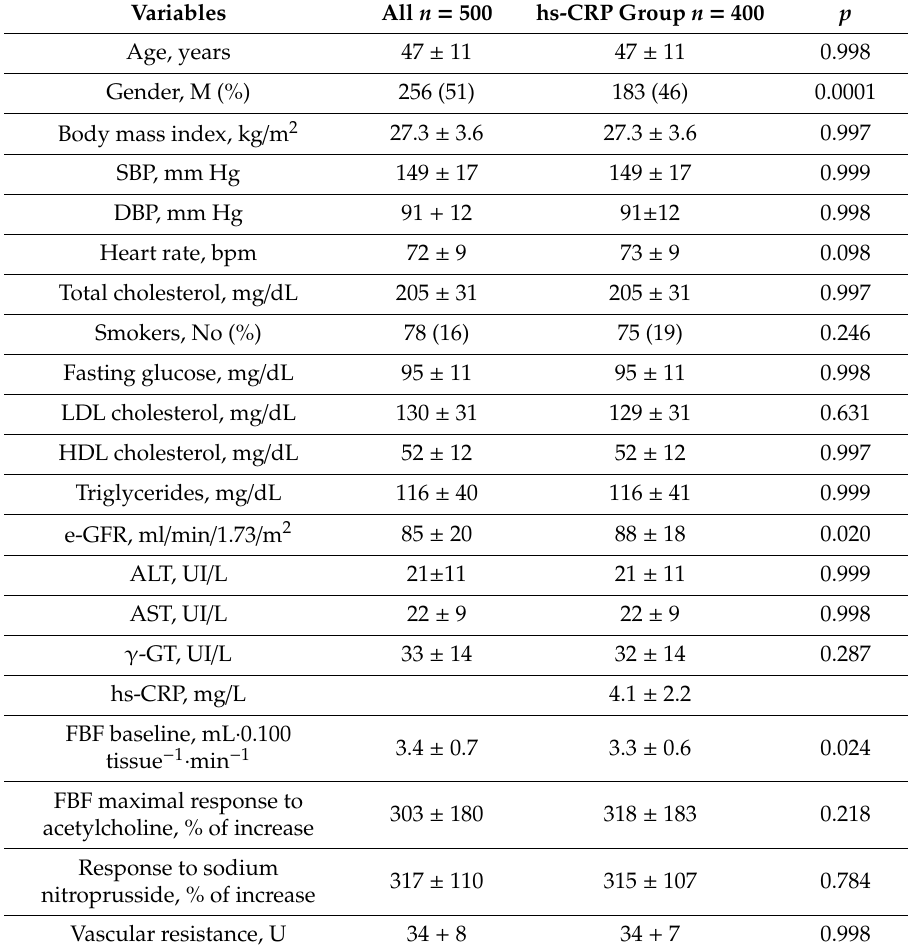
Table 1. Baseline characteristics of the whole study population and of the subgroup of patients with hs-CRP